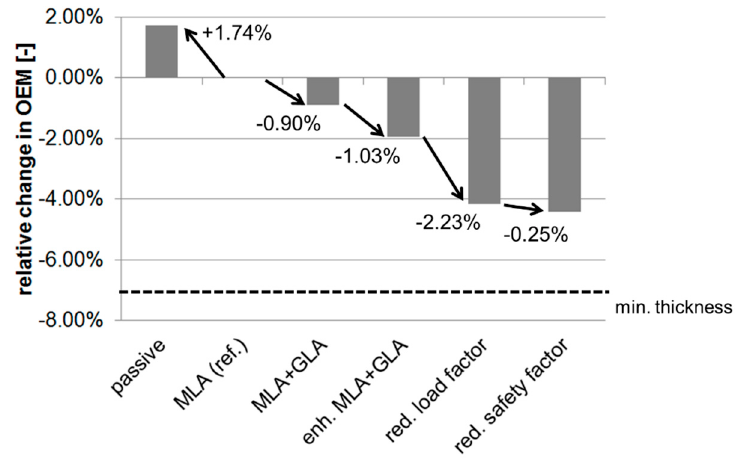
Figure 50. Overview of the change in